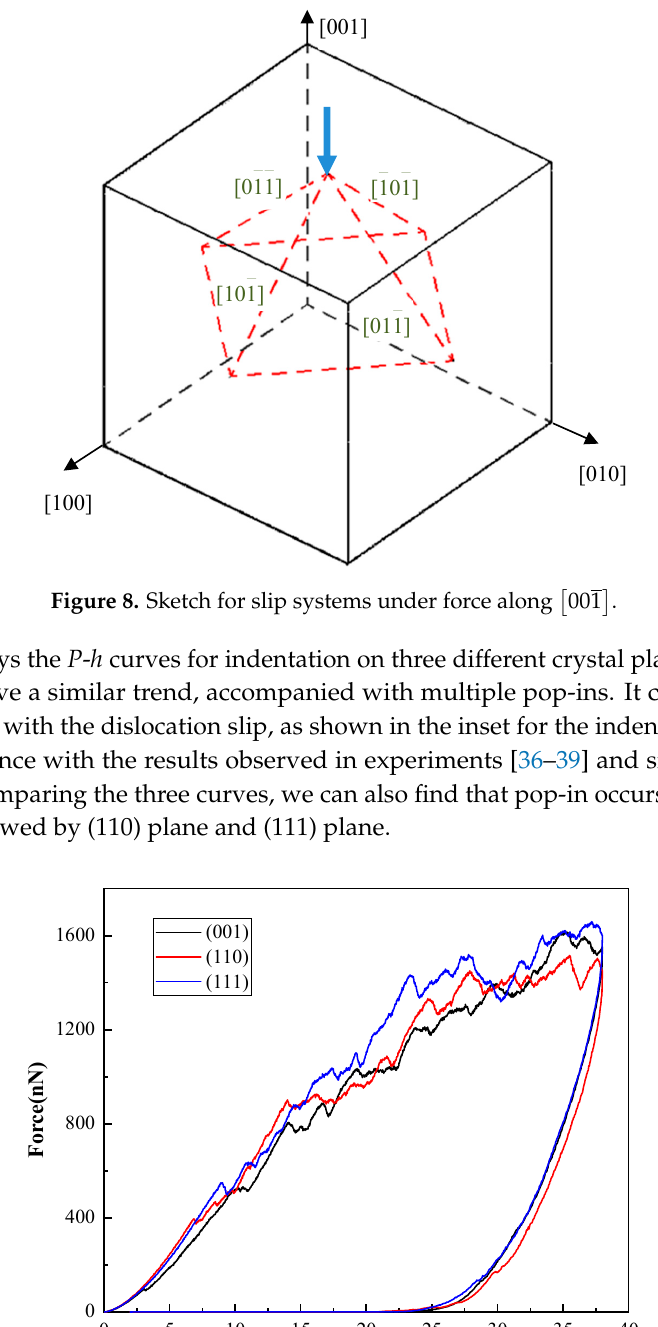
Figure 9. P - h curves of indentation on three B3-GaN surfaces. Inset shows distribution of dislocations in the sample under indentation on (111) plane as pop-in event happens.